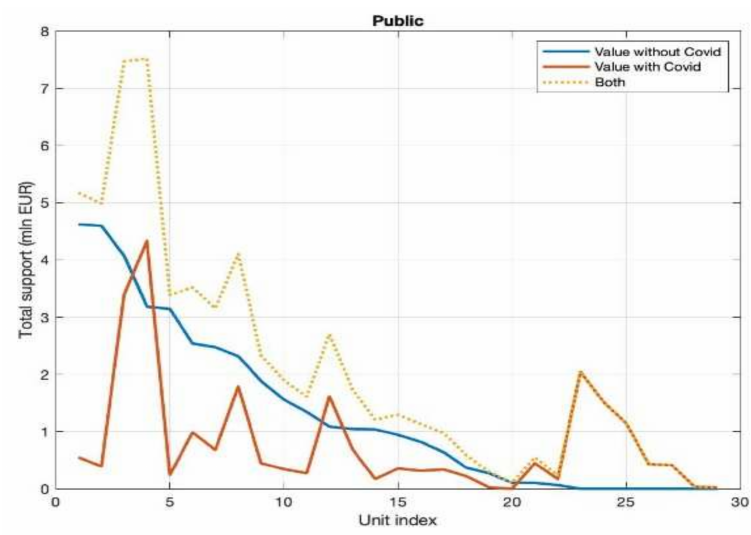
Figure 10. Support characteristics—public sector (COVID division, without